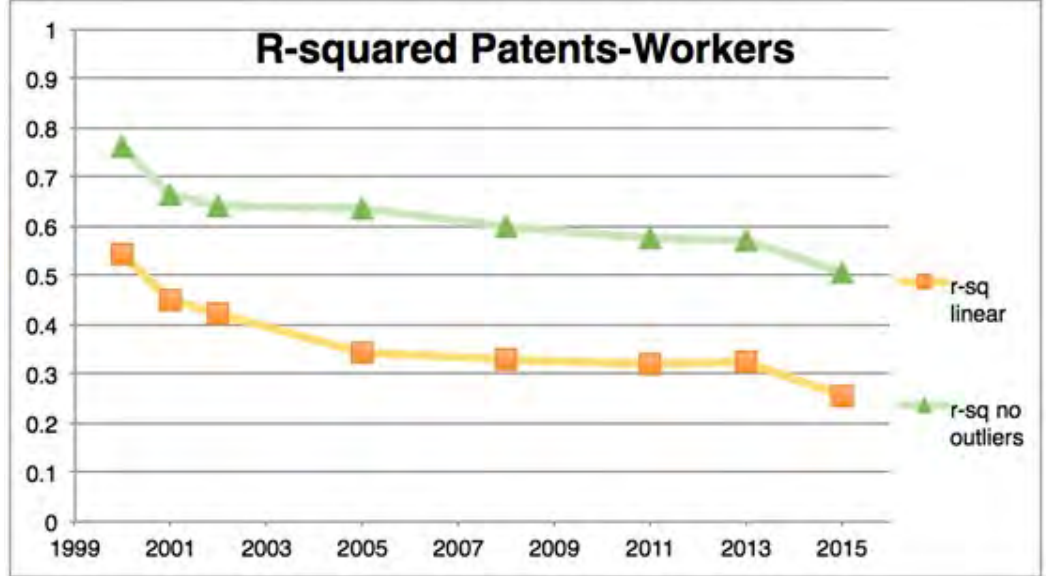
Figure 3. Coefficient of determination trend from 2000 to 2015 between patents and workers for US metro areas with and without outliers.